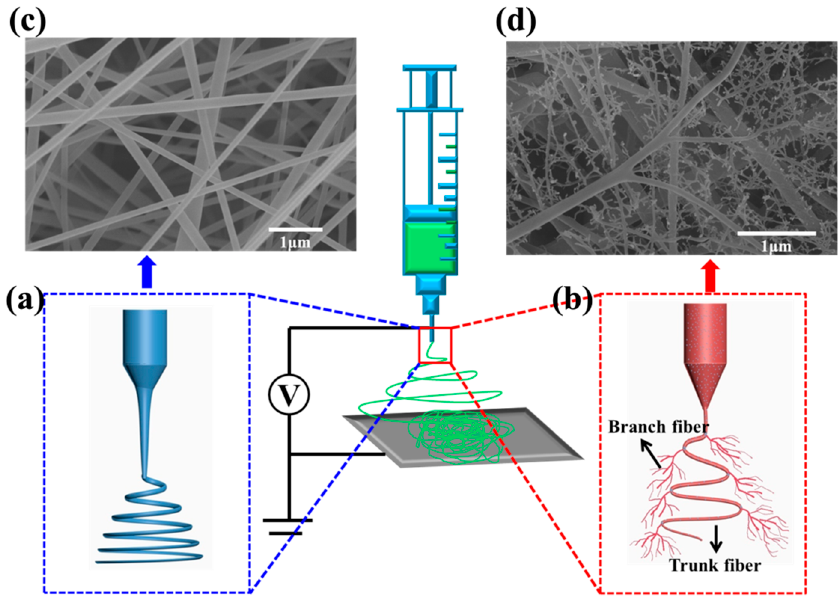
Figure 2. Schematic diagram for the electrospinning process of ( a ) pure PVDF solution and ( b ) PVDF/TBAC solution; ( c ) FE-SEM images of polyvinylidene fluoride nanofiber membranes (PVDF-NMs) and ( d ) PVDF-TLNMs.